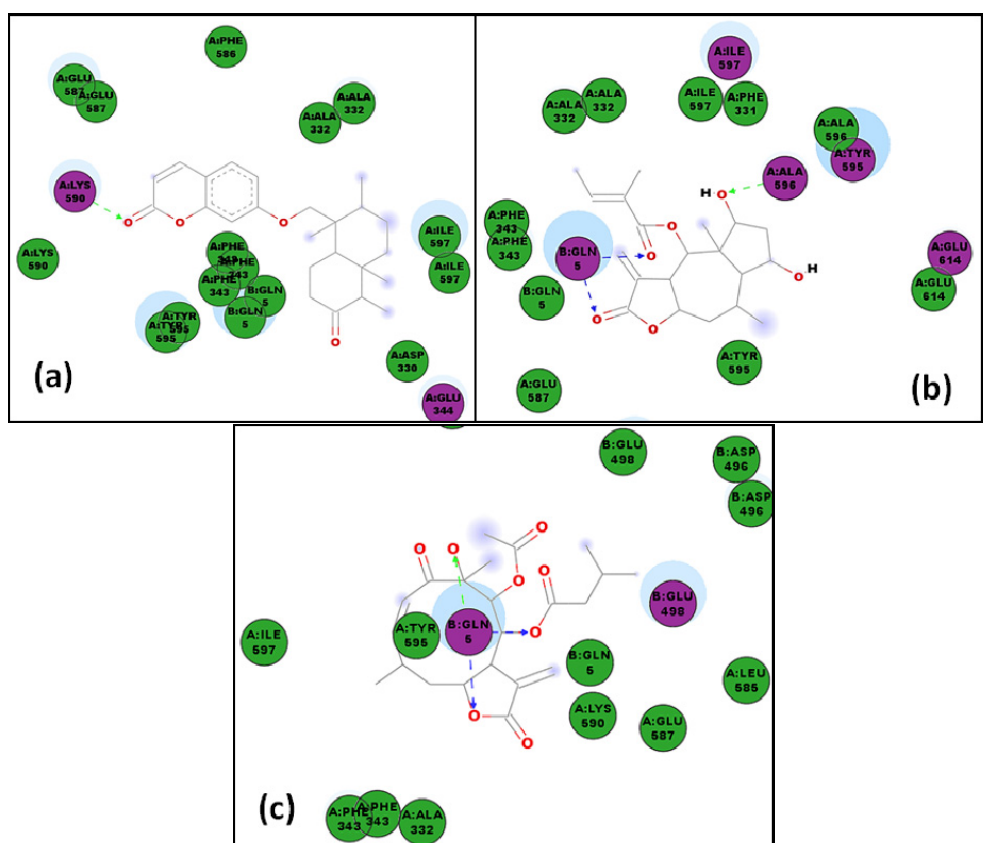
Figure 15. 2D representation of protein ligand interactions with Lm TryS of: ( a ) compound 1 ; ( b ) compound 64 ; ( c ) compound 80